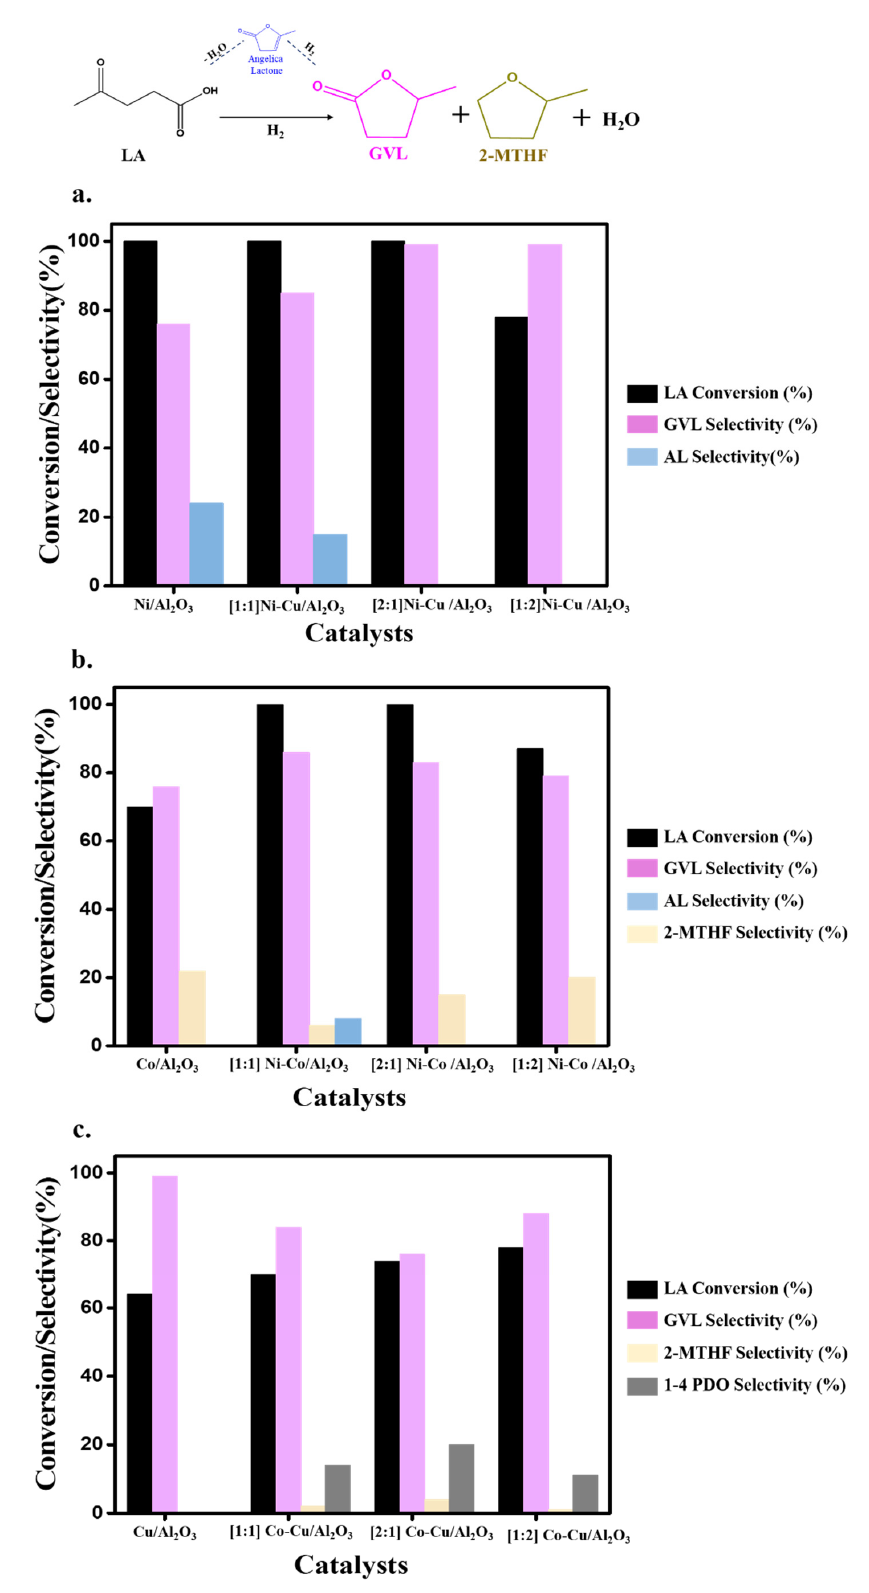
Figure 8. Levulinic acid (LA) conversion and product selectivity over ( a ) Ni-Cu-based catalysts, ( b ) Ni-Co-based catalysts, and ( c ) Co-Cu-based catalysts under a solvent-free condition. Reaction conditions: 20 mL LA, 1 g catalyst, 220 °C, 30 bar H 2 pressure, and A 6 h reaction time.